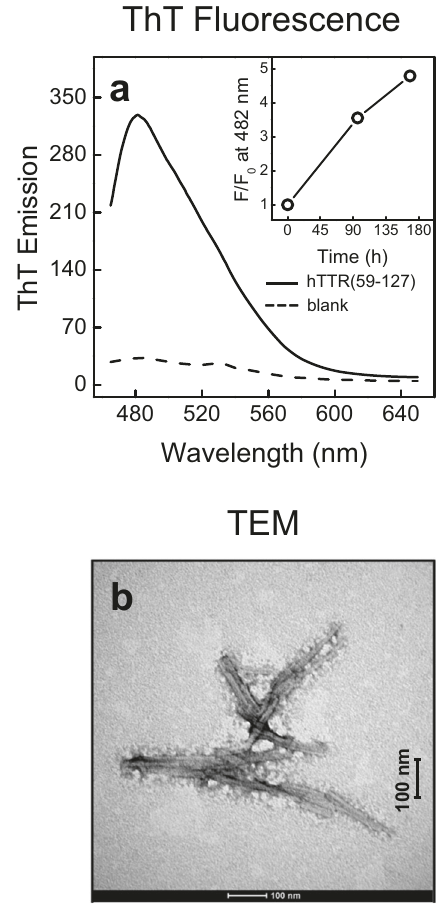
Fig. 7 Analysis of hTTR(59 – 127) amyloid fi bril formation. RP-HPLC puri fi ed fragment was lyophilized and dissolved (0.23 mg/ml) at 25 °C in TBS, pH 7.4. Amyloid fi bril formation was tested by ThT binding assay and TEM soon after solubilization of the fragment in TBS. a ThT fl uorescence emission in the presence (continuous line) or absence (dashed line) of hTTR(59 – 127). Measurements were carried out after 1-h incubation of ThT (20 µ M) with hTTR(59-127) (50 μ g/ml) and sample excitation at 450 nm. Inset: Time-dependent relative fl uorescence emission ( F / F 0 ) of ThT (white circles) in the presence of hTTR(59 – 127), where F and F 0 is the fl uorescence intensity recorded after incubation with hTTR(59 – 127), as indicated. b Representative TEM micrograph of hTTR(59 – 127)